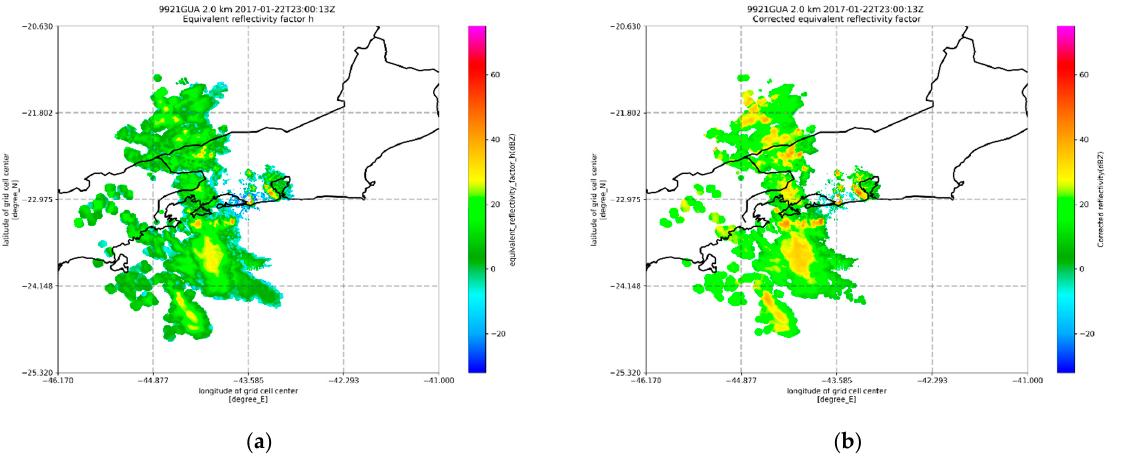
Figure 2. Illustration of different products of Guaratiba’s S-band radar reflectivity ( a ) without ZPHI- method correction and ( b ) with the reflectivity corrected by the ZPHI methodology.